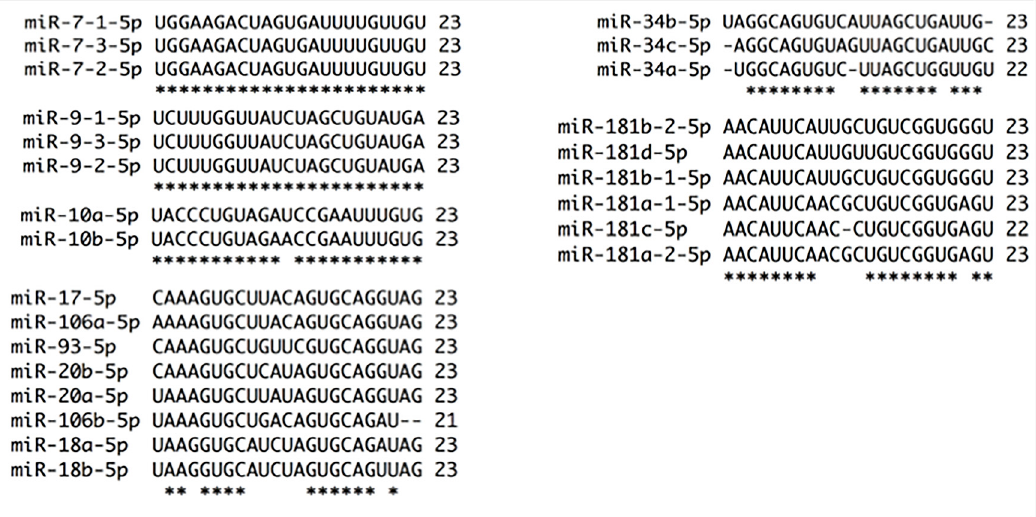
Figure 1. Alignments of miRNAs families by strand 5p selection and nt chain sizes. Six miRNA families were chosen by strand selection and nt chain size. Almost all members of these families are 23 nt in length, except miR-34a, and share high sequence conservation. miR-7 and miR-9 families have 100% of homology, miR-10 family varies only in 1 nt, miR-181 family is dissimilar in 3 nt, miR-17 family has five different nt, and miR-34 family presents six dissimilar nt. * at the bottom of the alignment indicates nt homology between family members.